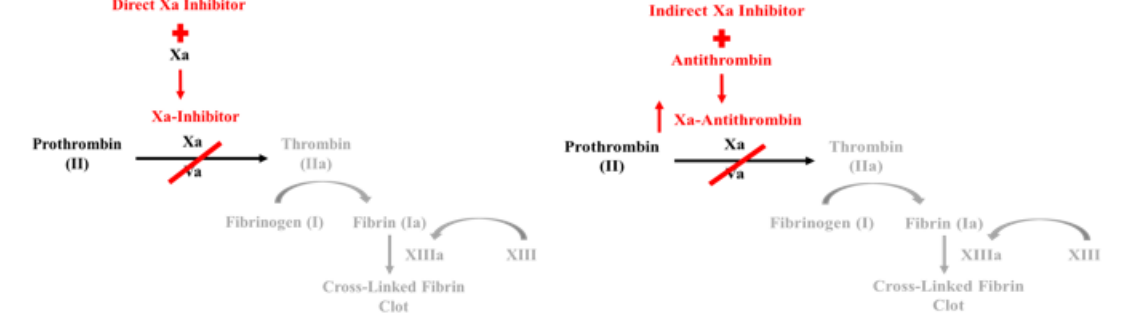
Figure 3. Mechanism of Action for Factor Xa Inhibitors.